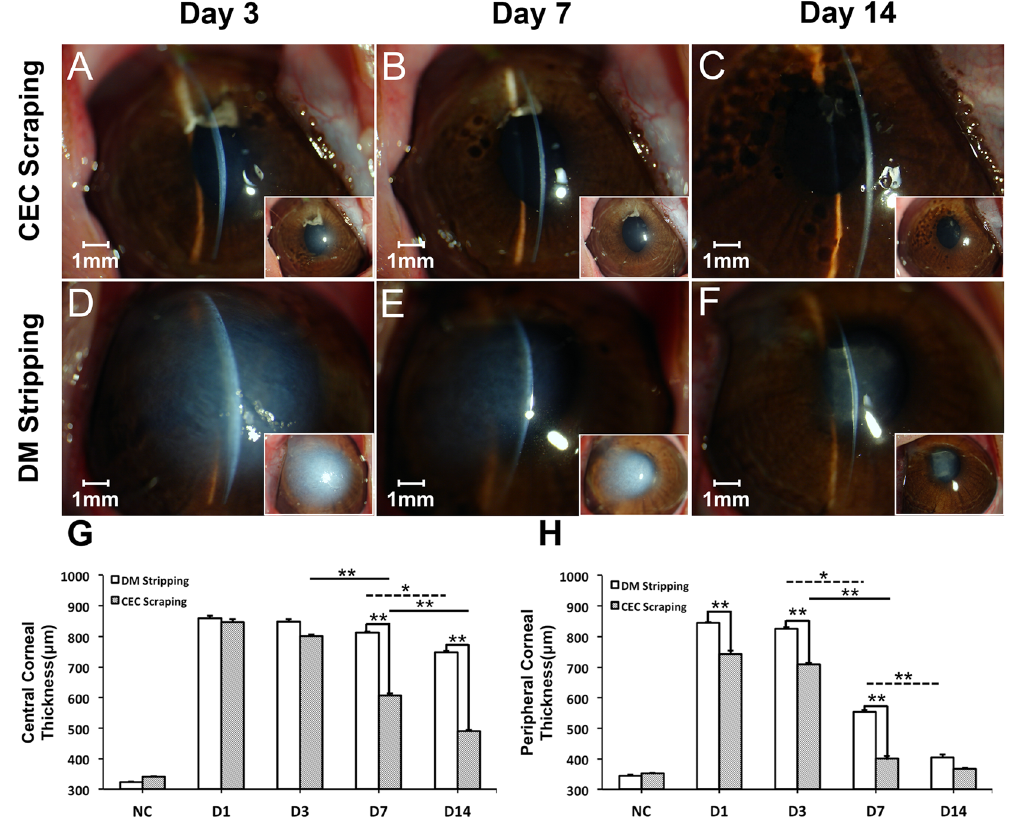
Figure 2. Slit-lamp microscopy observation and corneal thickness change after CEC injury. Slit-lamp microscope image of rabbit cornea after CEC scraping injury ( A , B , C ) or DM stripping injury ( D , E , F ) for different durations. Both central corneal thickness ( G ) and peripheral corneal thickness ( H ) dramatically increased one day after the endothelial injury (D1), compared with that of the normal control before injury (NC). After that, there was gradual decrease of central and peripheral corneal thickness in both groups from day 3 to day 14 ( * p < 0.05; ** p < 0.01). Central corneal thickness was higher in DM stripping group at day 7 and day 14 ( ** p < 0.01), while peripheral corneal thickness was higher in DM stripping group at day 1, day 3, and day 7 ( ** p <